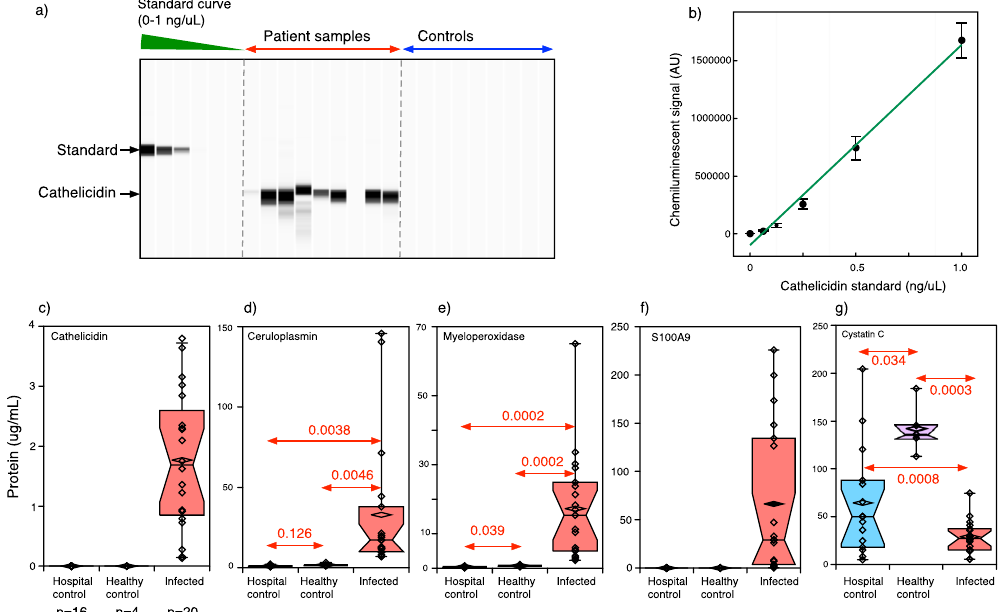
Figure 6. Automated western blotting of selected CSF proteins. Five proteins (cathelicidin (panel c), ceruloplasmin (panel d), myeloperoxidase (panel e), protein S100A9 (panel f) and cystatin C (panel g) were quantified in a larger cohort (n = 40, 15 hospital controls, 5 healthy controls and 20 SPP patients) using automated capillary western blotting ( Wes, ProteinSimple, CA, USA ). A typical ‘pseudo-gel image is shown in panel a, highlighting the position of the GST:cathelicidin fusion standard protein and the native cathelicidin the corresponding standard curve (panel b). Purified recombinant proteins were used as calibration standards for all five proteins. Panels c to g are the summarised quantitative western blot data for cathelicidin, ceruloplasmin, myeloperoxidase, S110A9 and cystatin C respectively. Dots show individual results for SPP samples (red) and hospital controls (blue) and healthy controls (purple). Top and bottom of the box represent the 75% (Q3) and 25% (Q1) percentile, the band inside the box is the median and whiskers extend to 1.5 times the interquartile range from the box. Points outside the box are outliers. For each protein, t-tests were used to assess the differences between